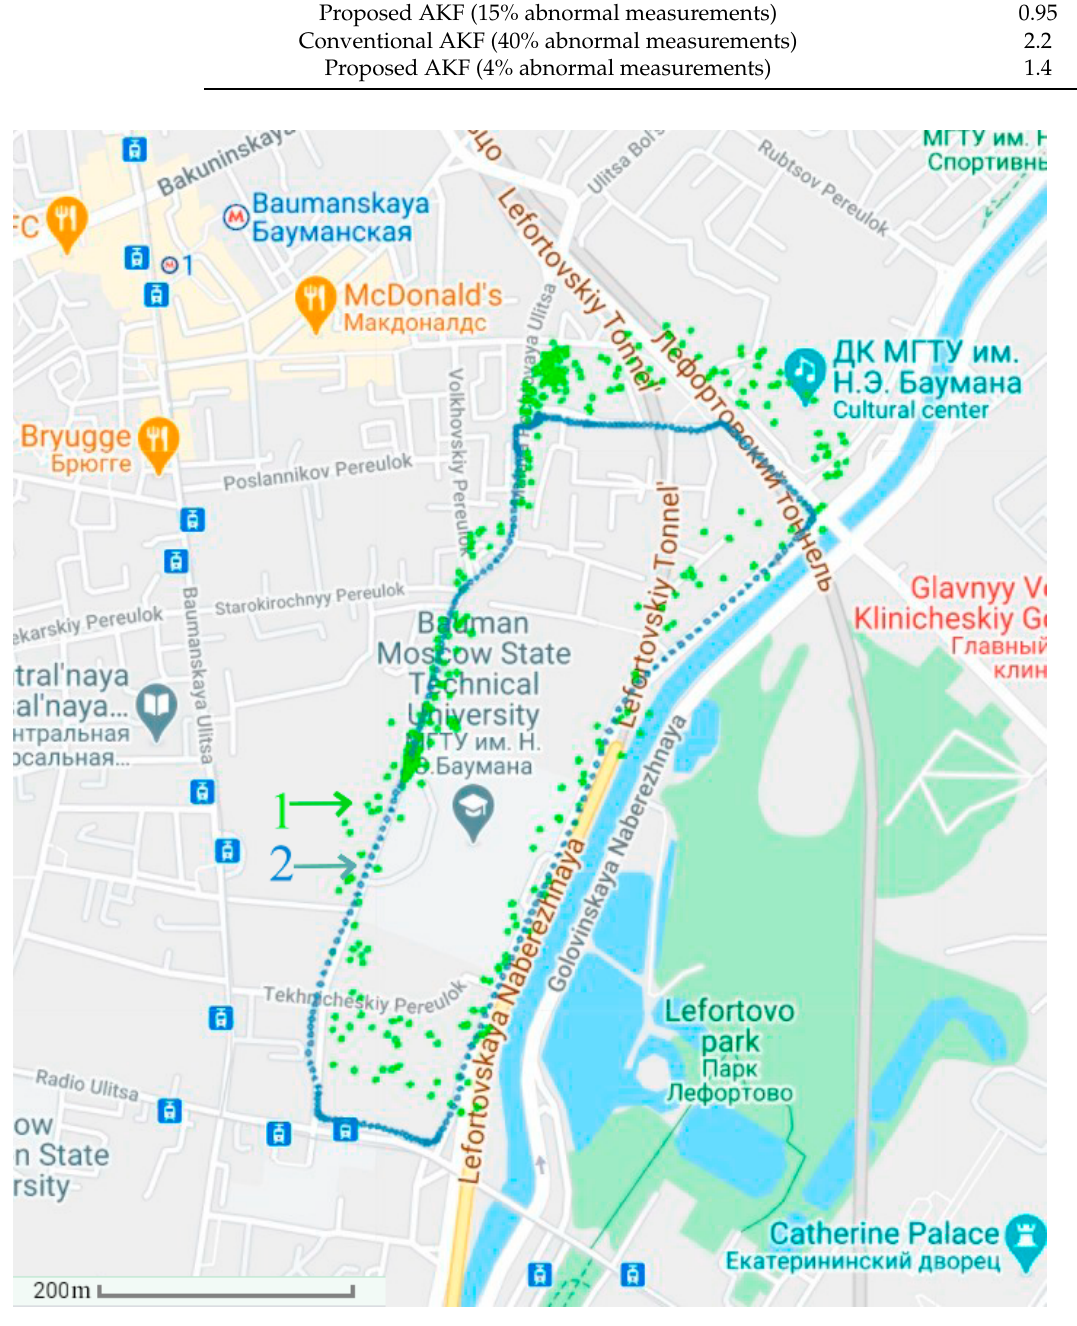
Figure 4. The positioning results of autonomous SINS: 1—positioning results; 2—actual